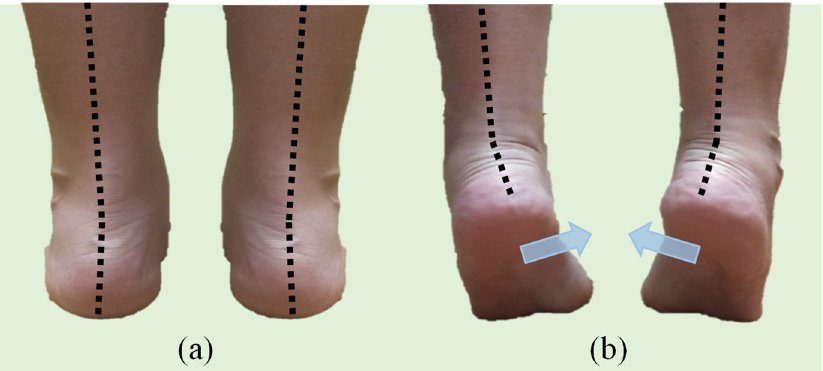
Figure 2. ( a ) Standing naturally; ( b ) inversion of the calcaneus during elevation.